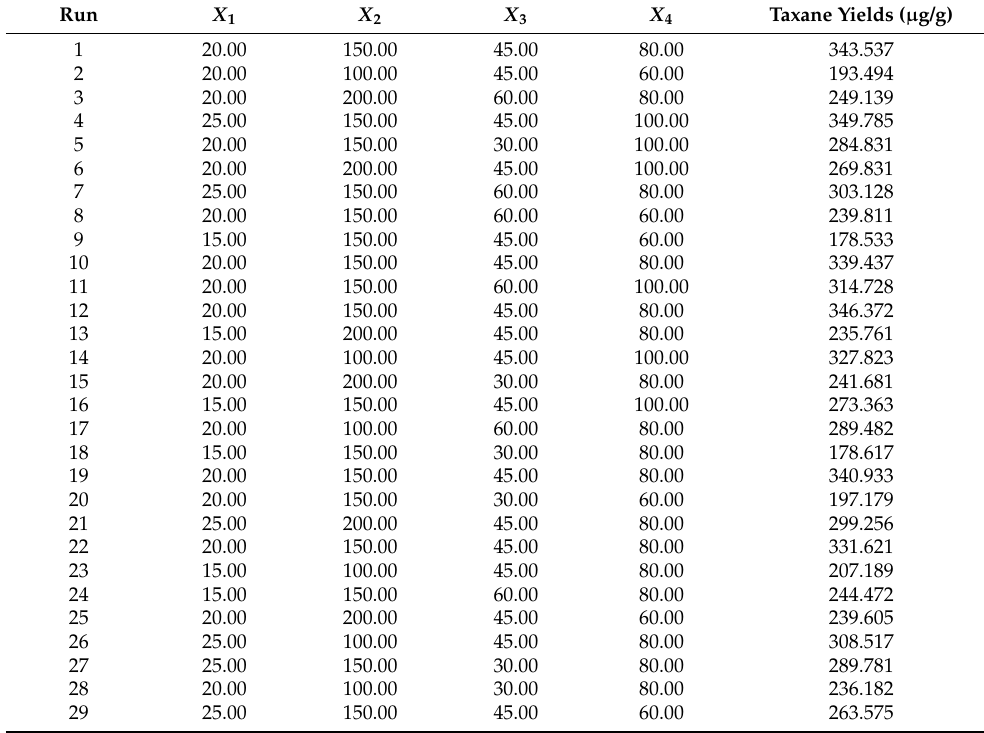
Table 3. Experimental design and results of Box–Behnken design (BBD).